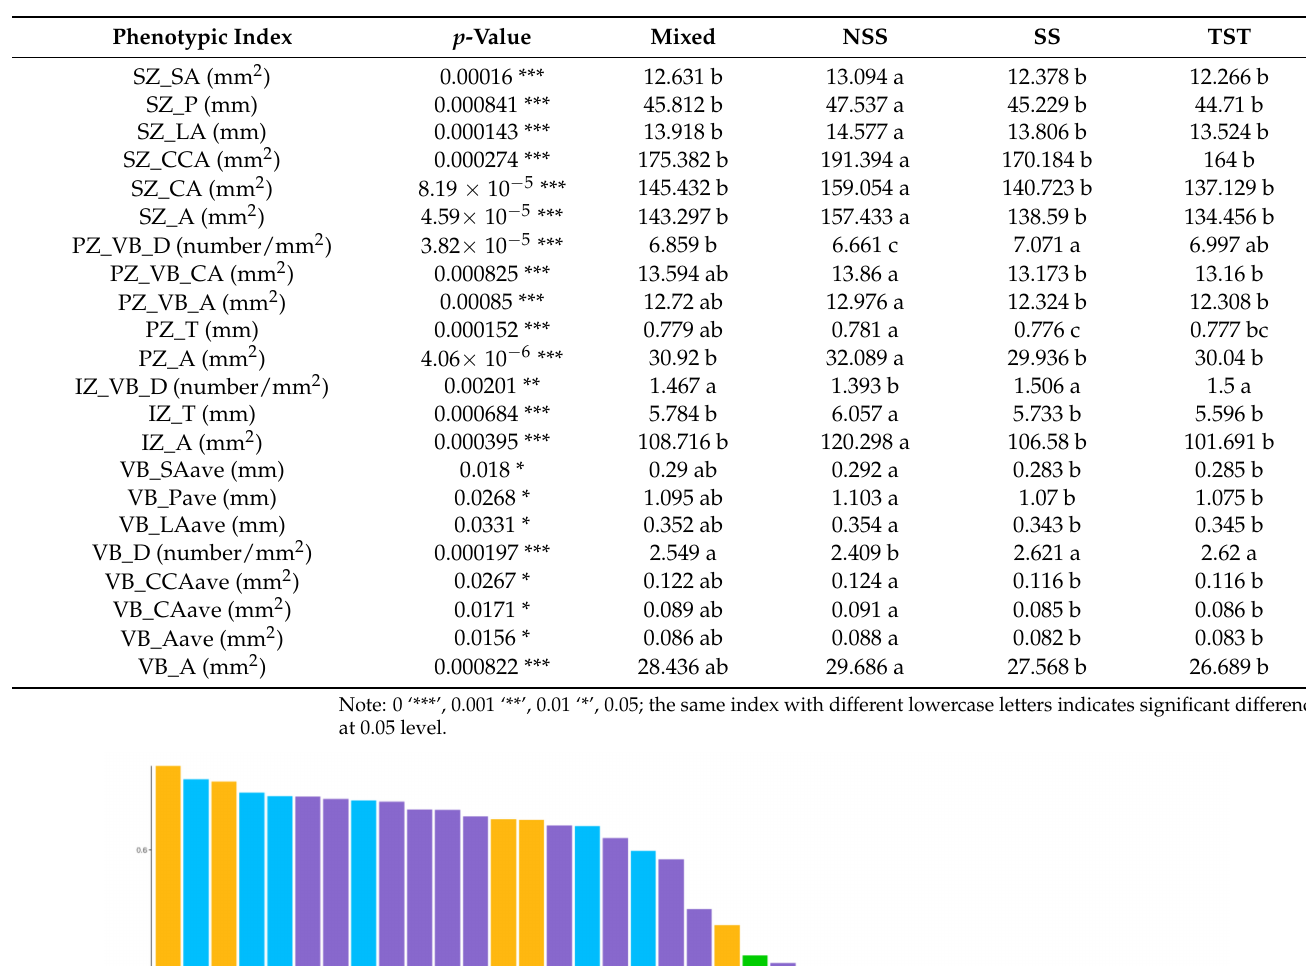
Table 2. The 22 phenotypic traits of the shank base internodes that showed significant differences among the subpopulations of 202 inbred lines (TST, NSS, SS and Mixed).